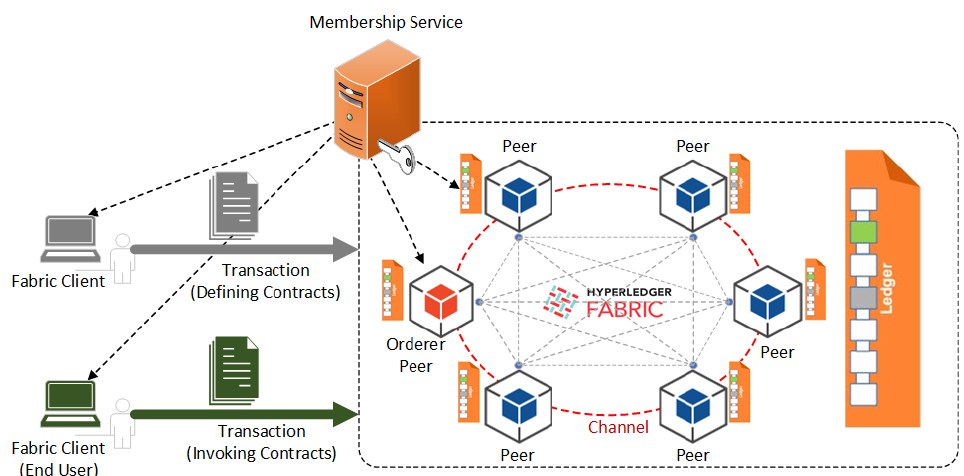
Figure 1. HLF network system architecture with its major components